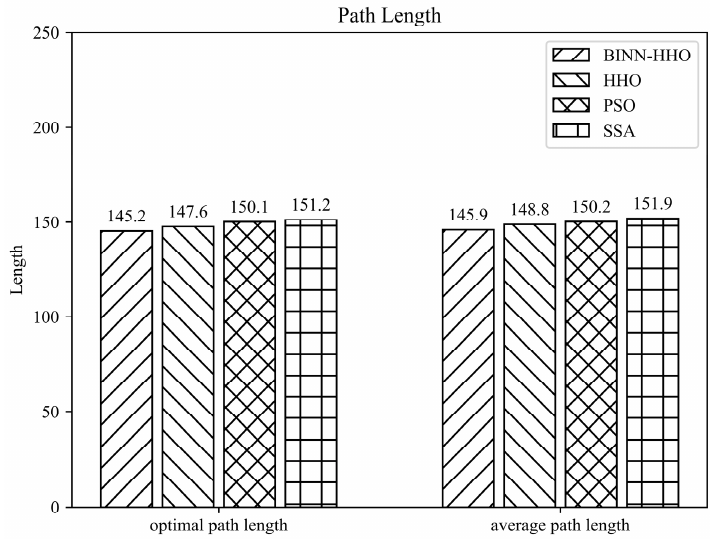
Figure 7. Path length of the competitor algorithms (unit: km).